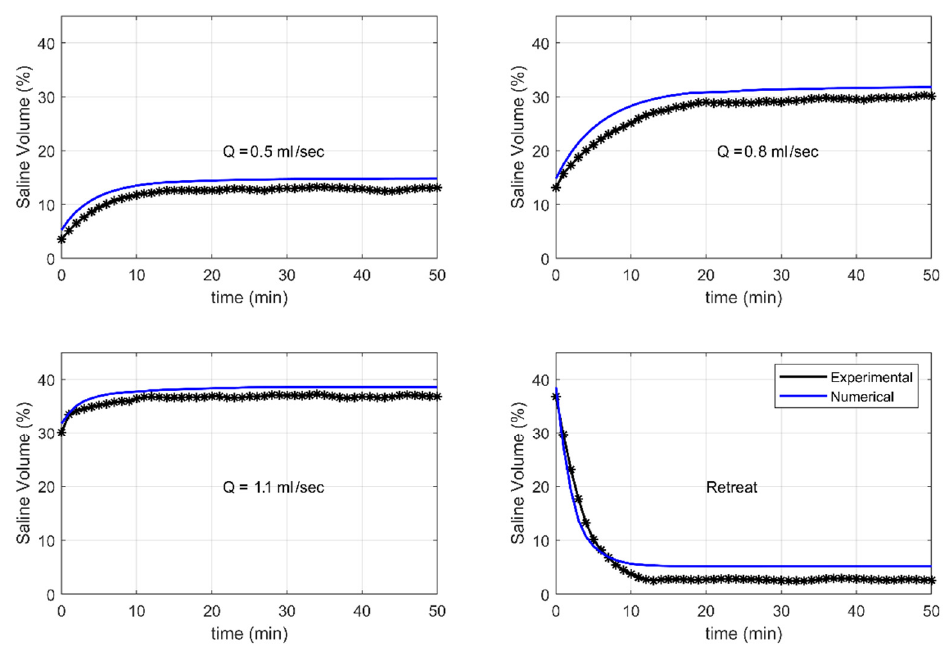
Figure 6. Transient experimental and numerical values of the saline volume fraction in the fractured-left aquifer, under an abstraction rate of 0.5 mL/s ( top left ), 0.8 mL/s ( top right ) and 1.1 mL/s ( bottom left ) as well as during the final saltwater retreat phase ( bottom right ).